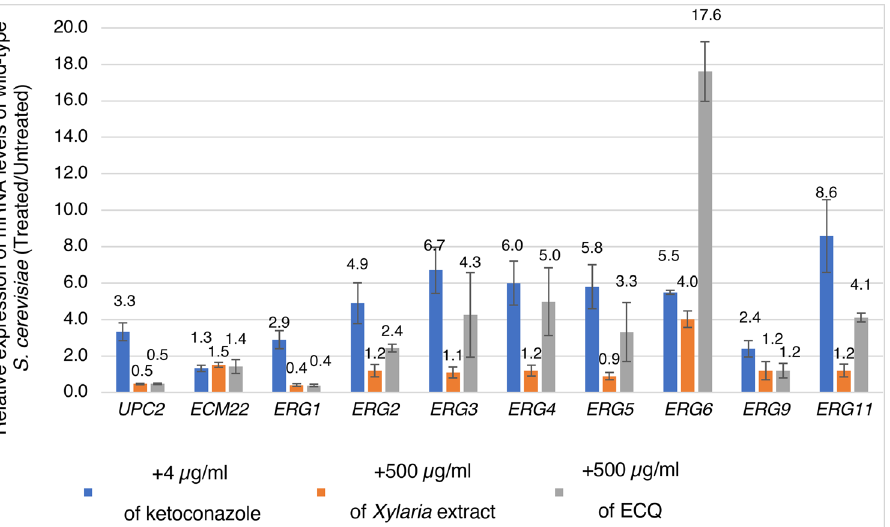
Figure 2. Relative expression of genes in ergosterol biosynthesis. S. cerevisiae BY4742 wild-type strain was treated with 4 µg/ml of ketoconazole, 500 µg/ml of Xylaria extract, or 500 µg/ml ECQ for 2 h. The relative mRNA levels of the treated cells were compared to the untreated cells and normalized with a housekeeping gene TDH3 . At least two independent qRT-PCR experiments were performed in triplicates. Error bars represent standard error of the mean